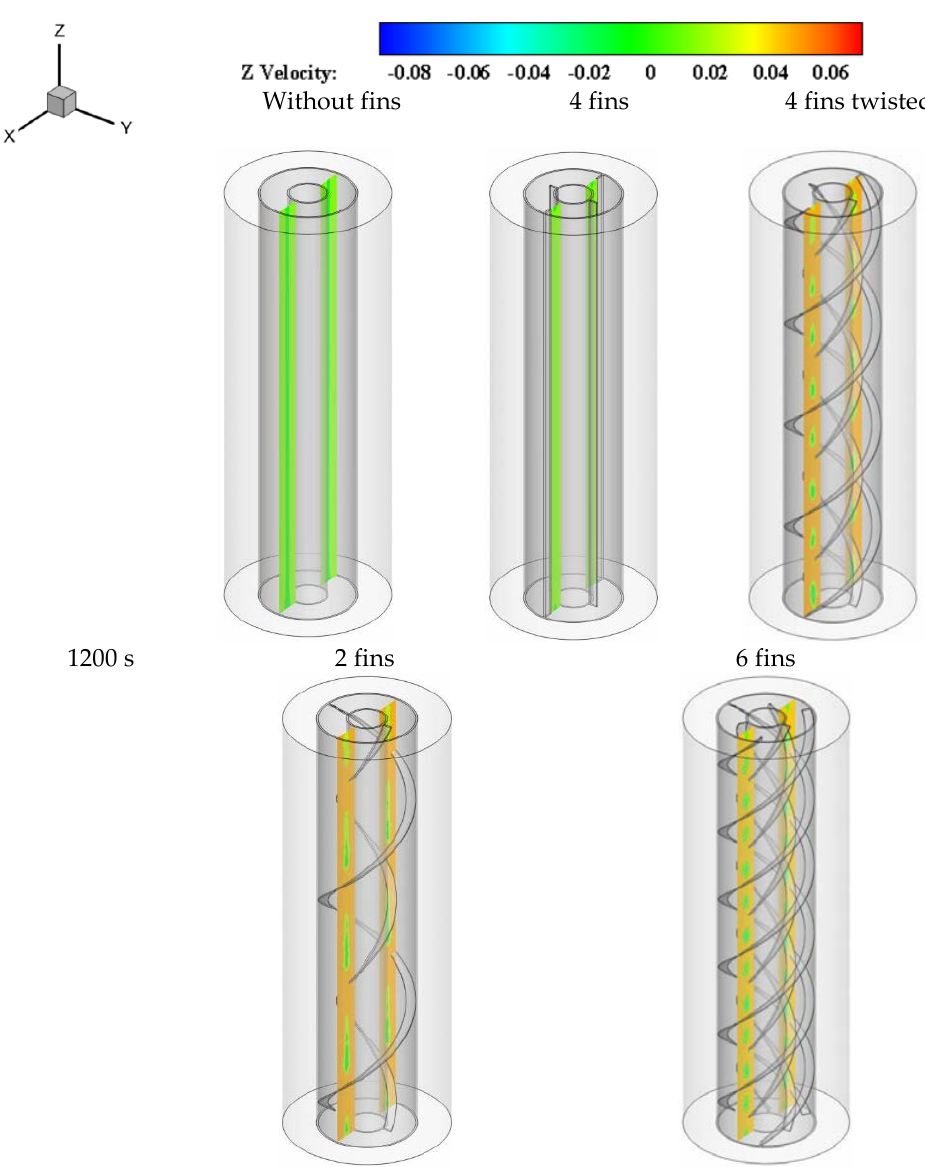
Figure 7. Time history of average temperature for the three different cases of twisted fins.